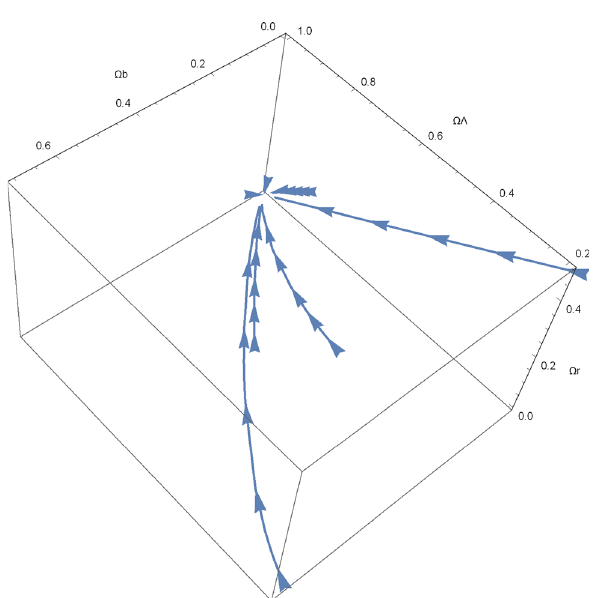
Fig. 1 Phase space diagram for the dynamical system (16), (17), (19). We consider (a) (cid:8) b = 0 . 2996 ,(cid:8) r = 0 . 0004, (cid:8) (cid:2) = 0 . 7, (b) (cid:8) b = 0 ,(cid:8) r = 0 . 1, (cid:8) (cid:2) = 0 . 9, (c) (cid:8) b = 0 . 3, (cid:8) r = 0 . 2, (cid:8) (cid:2) = 0 . 5, (d) (cid:8) = 0, (cid:8) = 0 . 5, (cid:8) (cid:2) = 0 . 2, (e) (cid:8) = 0 . 7, (cid:8) = 0 . 1 , (cid:8) (cid:2) = 0 . 2, for b r b r n < 1. The unique attractor is the de Sitter point A 1